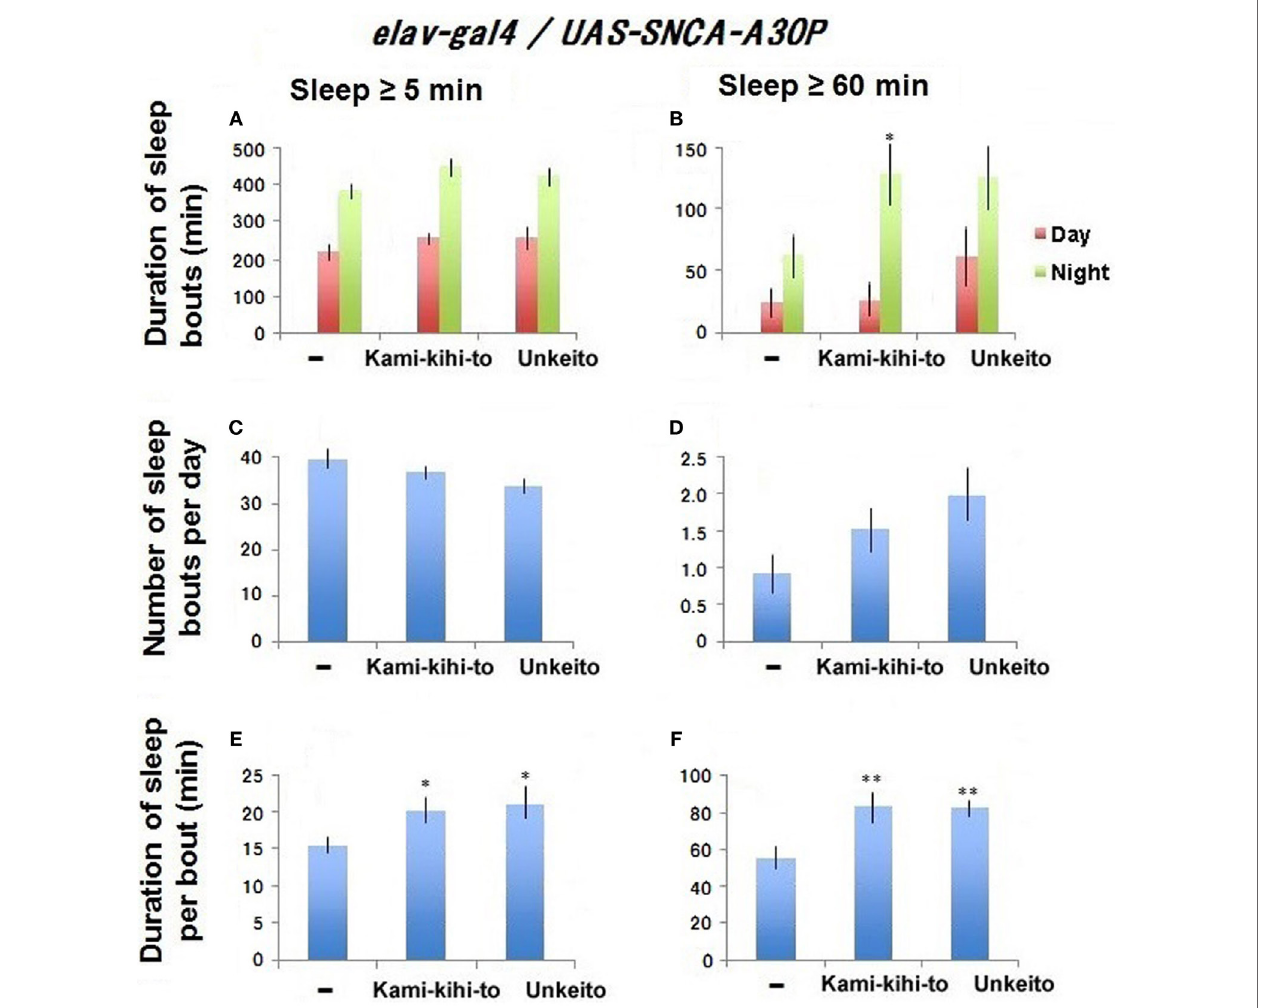
FigUre 3 | Sleep behaviors in A30P Parkinson’s disease (PD) model male flies fed with 1.6 × 10 − 3 g/mL Kamikihito ( n = 30 flies) and Unkei-to ( n = 26) in medium during 10–20 days after eclosion. A30P PD model flies with standard food are used as control ( n = 31). Sleep behaviors were measured between 18 and 20 days after eclosion. Sleep amount/day (a,B) , number (c,D) , and duration (e,F) of sleep bouts. Results are expressed as mean ± SEM. Data were statistically analyzed by one-way ANOVA, followed by Dunnett’s post hoc test. Obtained F values are as follows: (a) [day: F (3,115) = 0.91; p = 0.43, night: F (3,115) = 1.78; p = 0.15], (B) [day: F (3,115) = 1.26; p = 0.28, night: F (3,115) = 3.65; p = 0.014], (c) [ F (3,115) = 3.34; p = 0.021], (D) [ F (3,115) = 1.65; p = 0.18], (e) [ F (3,115) = 3.42; p = 0.019], (F) [ F (3,115) = 5.18; p = 0.0021]. * and ** represent significant differences ( p < 0.05 and p < 0.01,